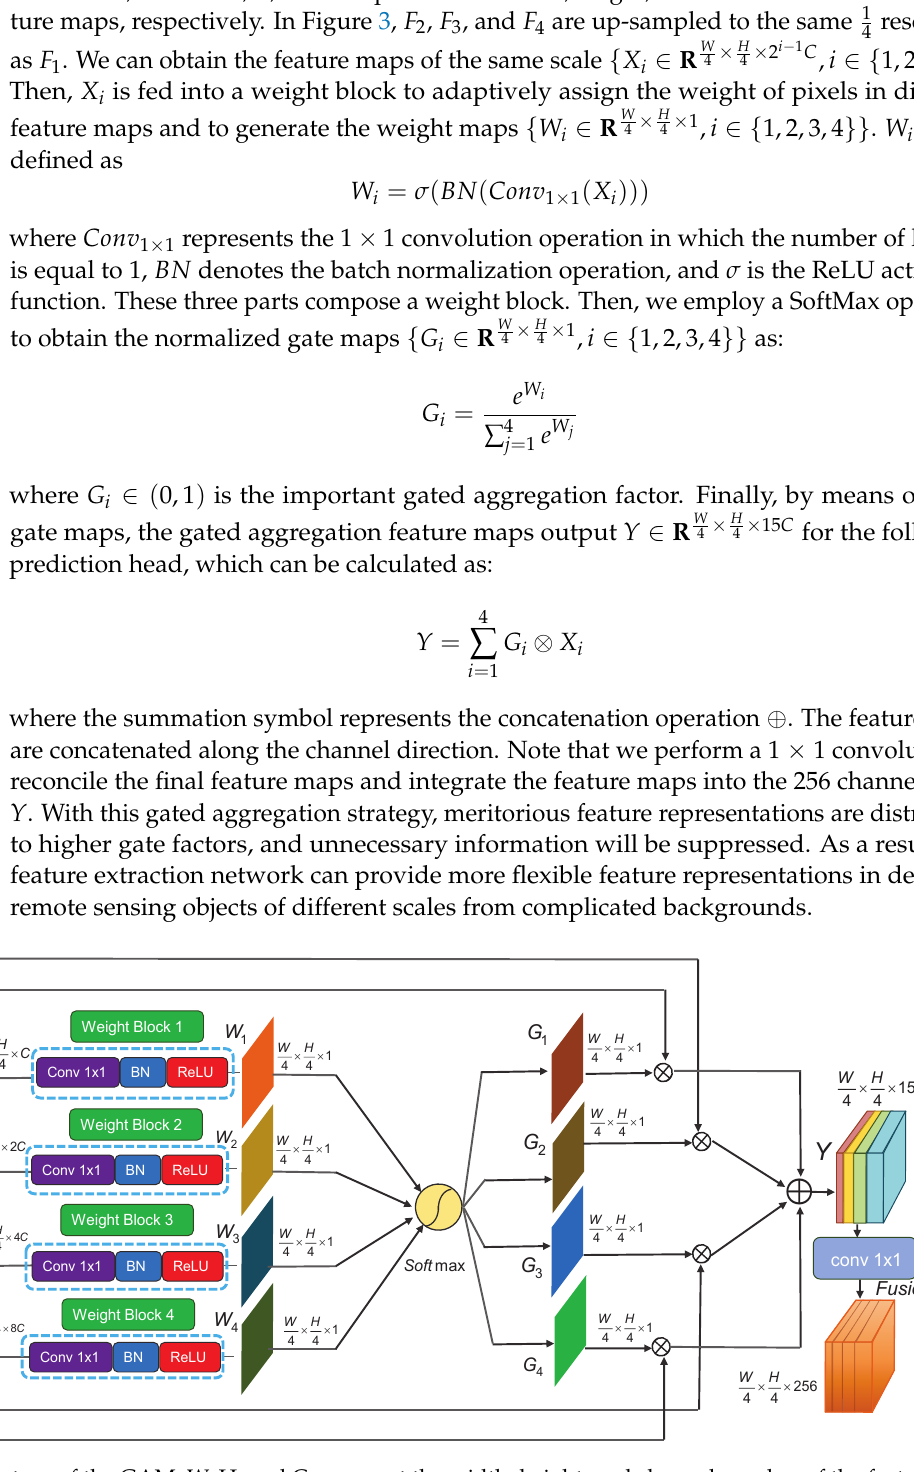
Figure 3. The network structure of the GAM. W, H, and C represent the width, height, and channel number of the feature maps, respectively. ⊗ represents the broadcast multiplication operation. ⊕ denotes the concatenation operation. Conv 1 × 1 is a convolution operation with 1 × 1 kernels, BN is a batch normalization operation, and ReLU is the ReLU activation function. A weight block is composed of a 1 × 1 convolution operation, a BN operation, and a ReLU